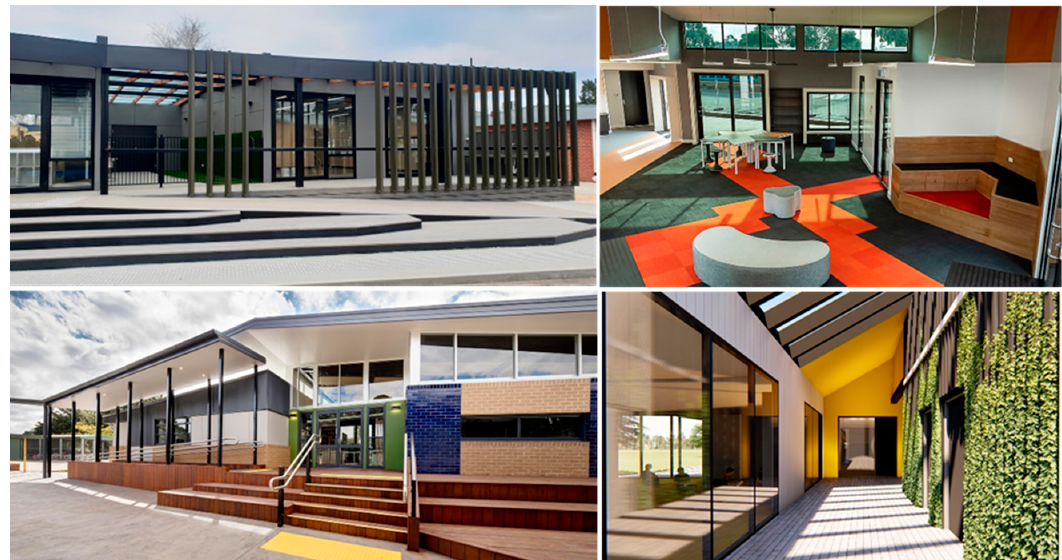
Figure 3. New modular schools built by the PMSB program of VSBA in 2018 – Mt Waverly Heights